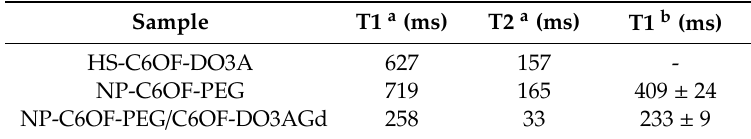
Table 2. 19 F Relaxation times determined for the fluorinated gadolinium-complexing ligand and NP-C6OF-PEG / C6OF-DO3AGd considering the signals at − 90.1 ppm.